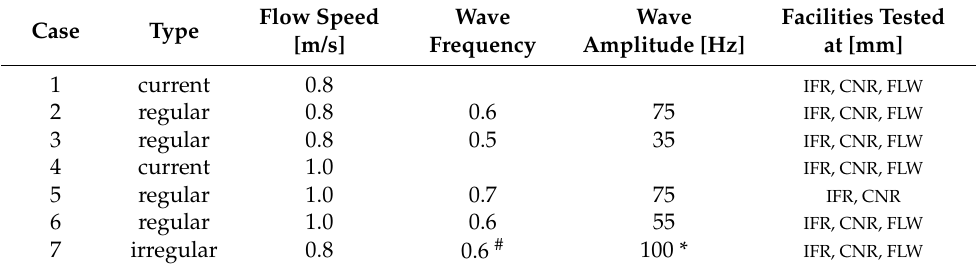
Table 4. Summary of the test